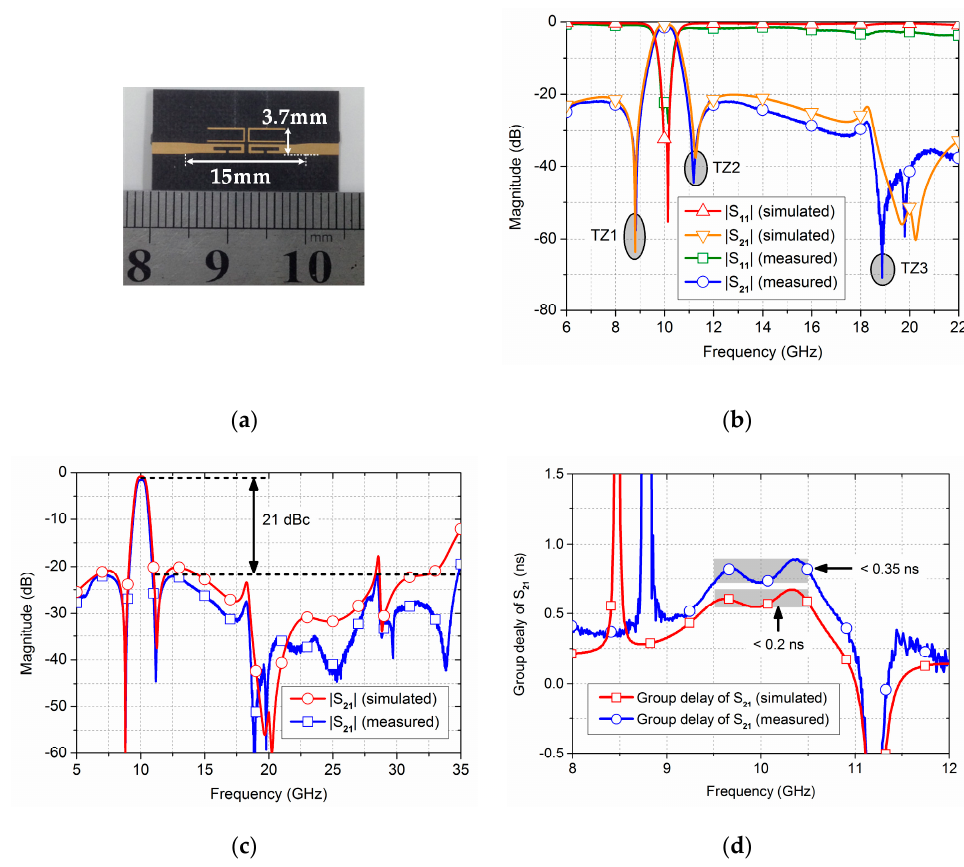
Figure 7. Photograph and measured results of the fabricated single-ended filter: ( a ) Photograph; ( b ) measured and simulated results; ( c ) wideband response of |S 21 |; ( d ) measured group delay.